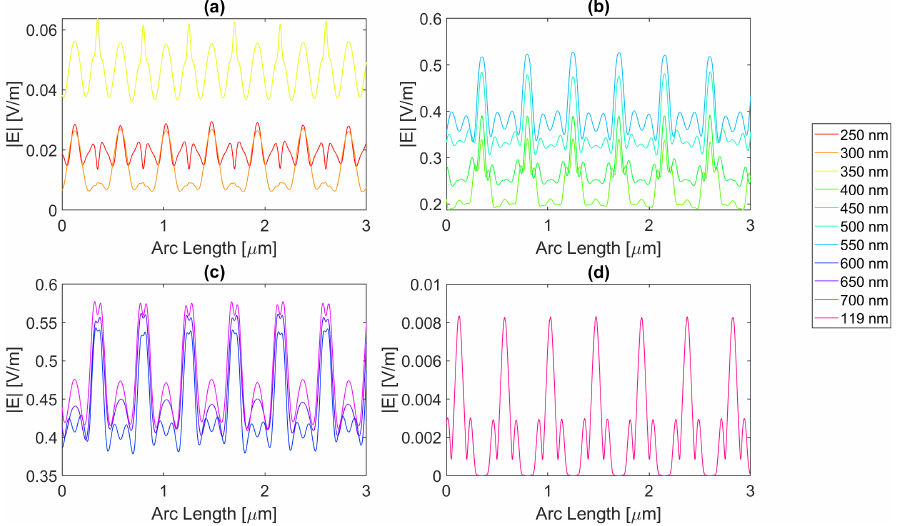
Figure 13. Electric field for the aluminium circular nanostructure with 100 nm radius—Probe 1.